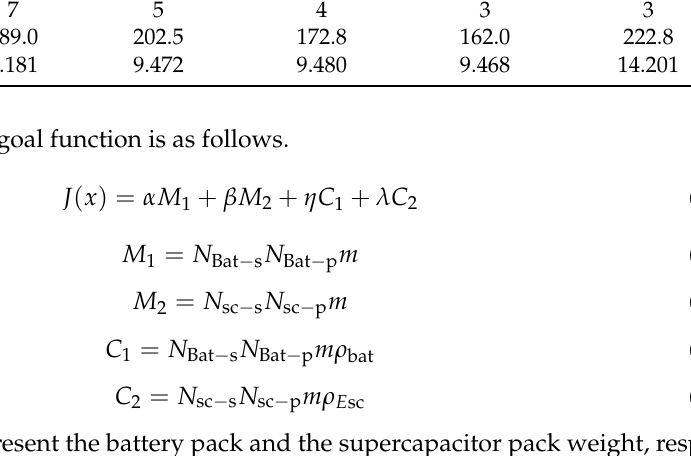
= 1500 F. Figure 3 shows the HESS parameter optimization results.